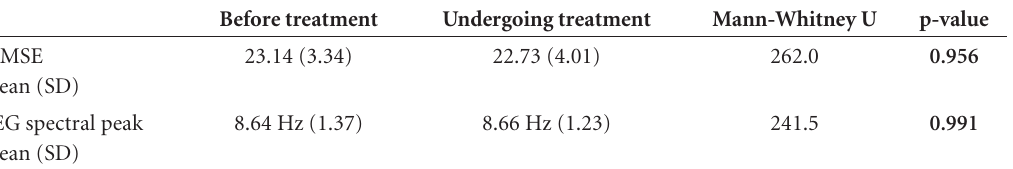
Table 3. Mann-Whitney test for cognitive performance and EEG spectral peak before and while undergoing AChEI treatment.